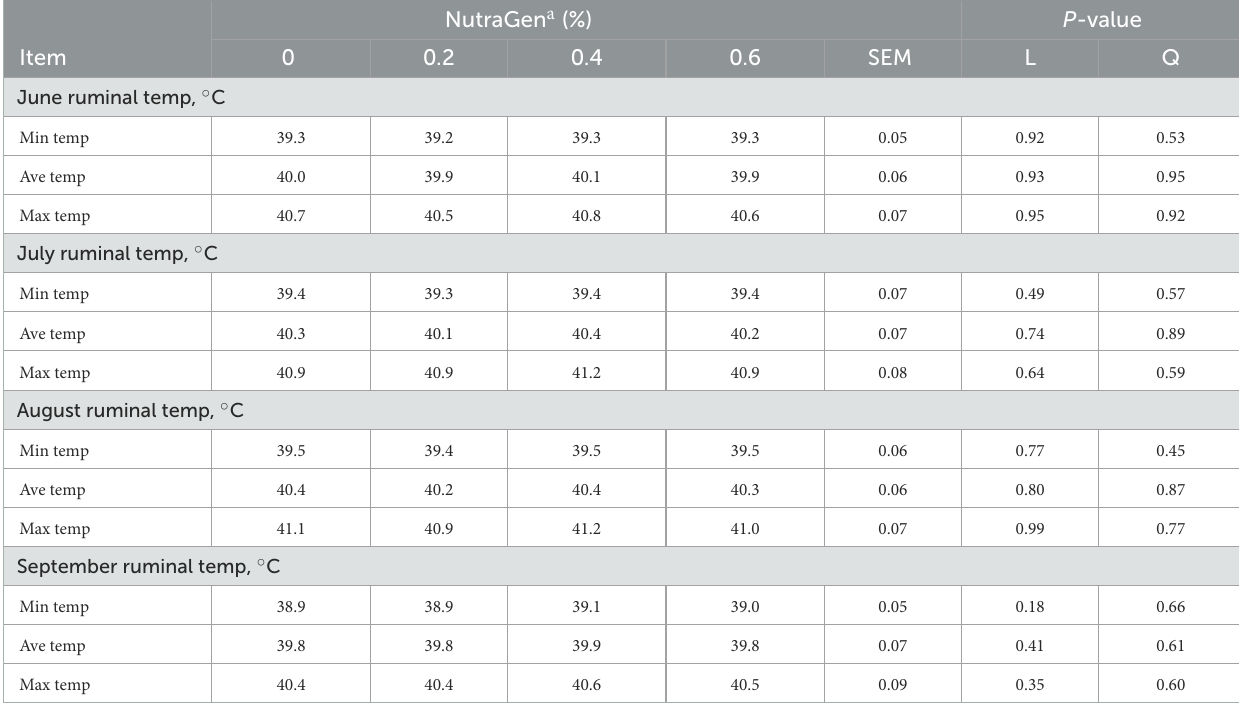
TABLE 4 Effects of feeding NutraGen supplement on ruminal temperature during summer months.